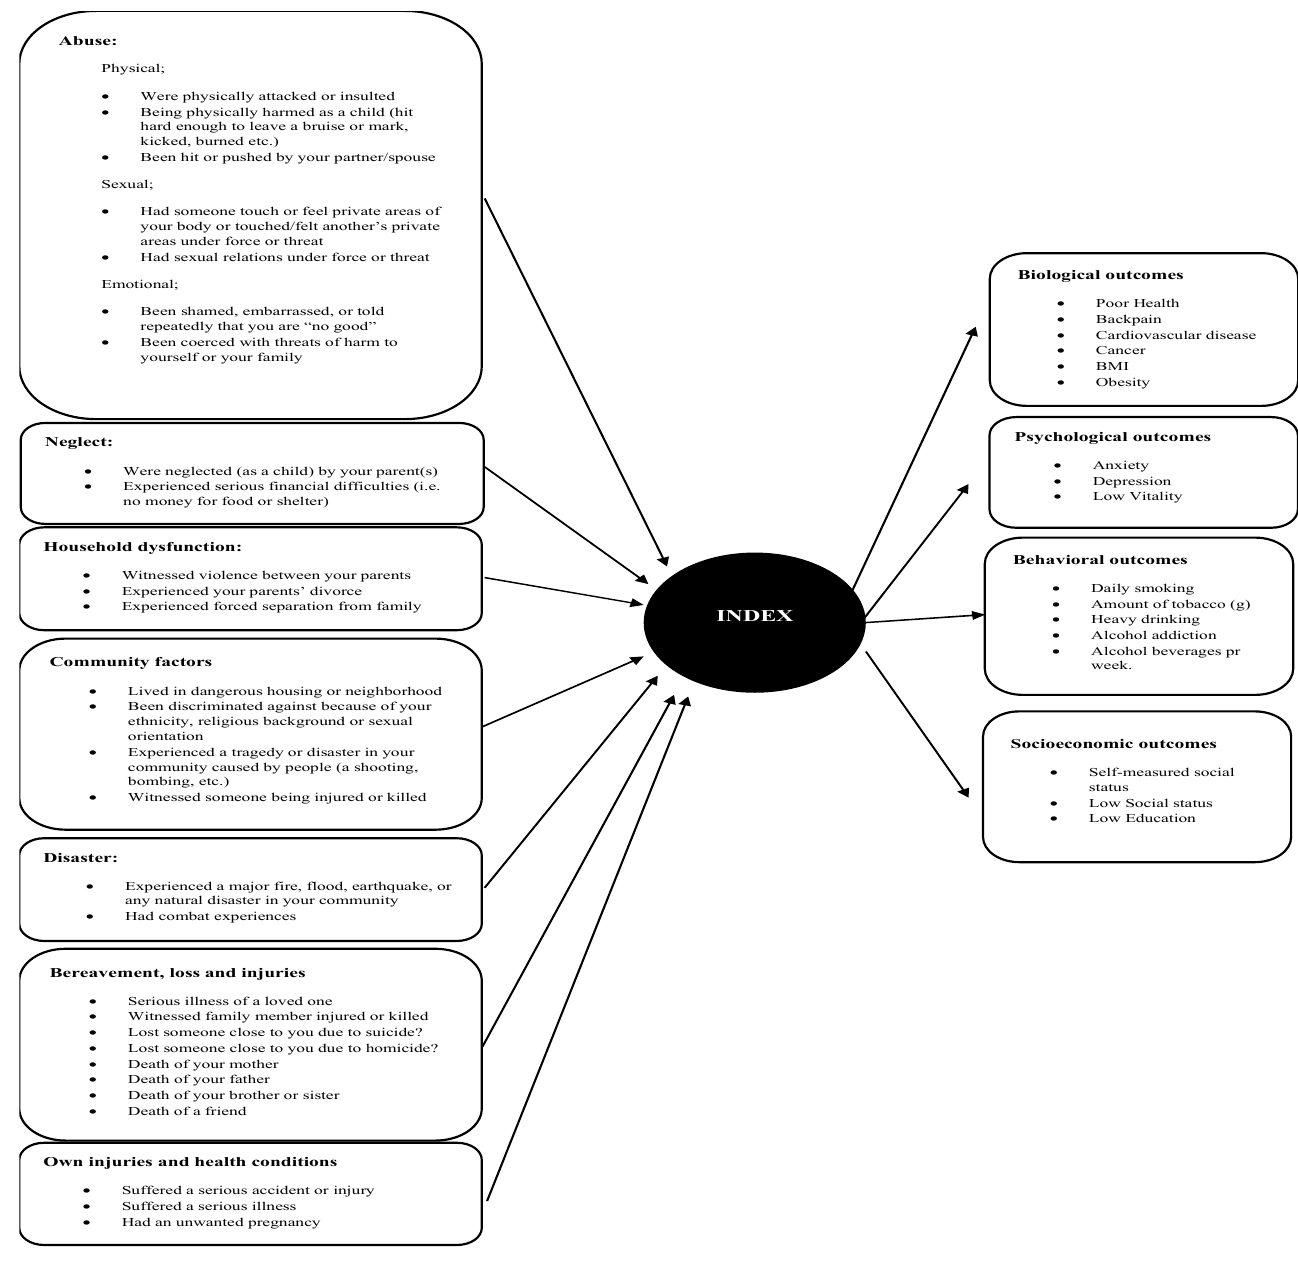
Figure 2. The WICAC showing the items forming the index. On the right side of the model, it shows the biopsychosocial outcomes from our hypotheses.